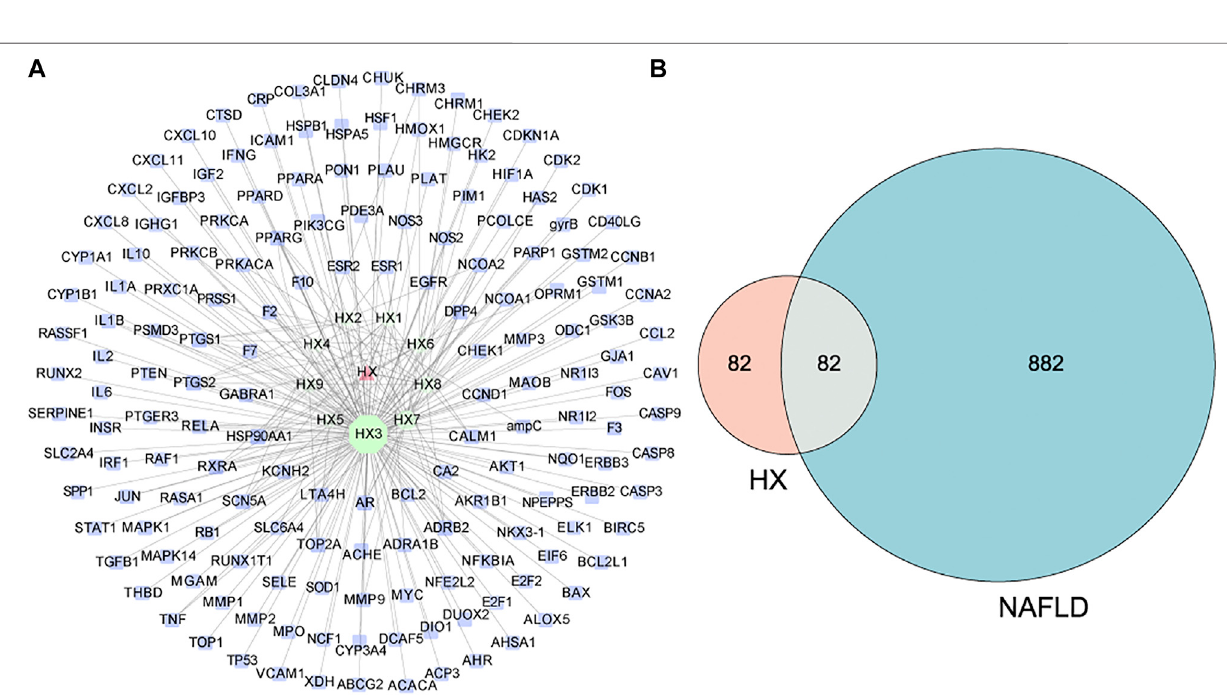
Frontiers in Pharmacology |